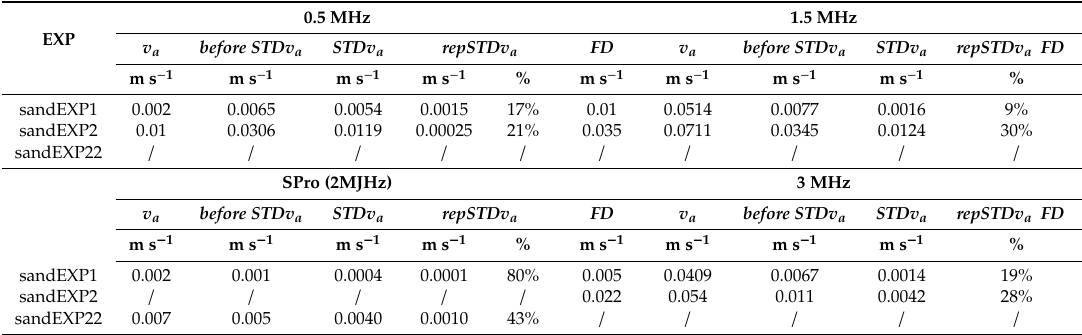
Table 6. The apparent bedload velocity deviation in the NTNU experiments. 0.5